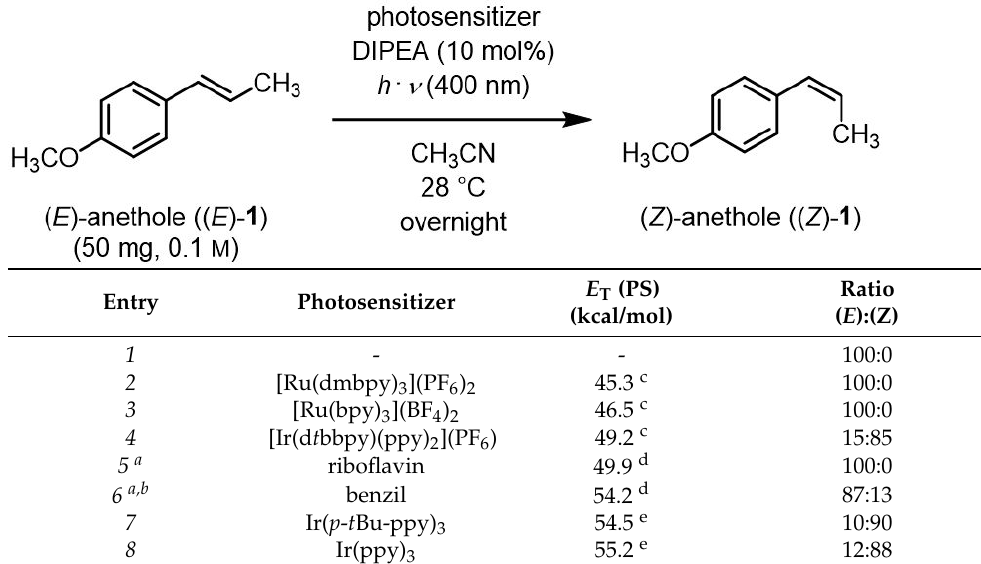
Table 1. Screening of photosensitizers regarding their potential to convert ( E )- into ( Z )-anethole. Organo-photosensitizers were used in an amount of 20 mol% and metal-based photosensitizers in an amount of 2 mol%, relative to ( E )-anethole. The transformations were determined by recording 1H NMR spectra of the crude